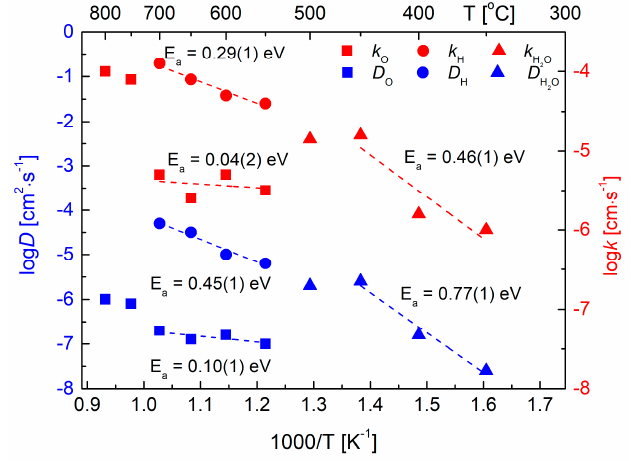
Figure 10. Temperature dependence of the transport coefficients D (blue) and k (red) with calculated values of the activation energy. Please notice description of the used symbols. Data shown in Arrhenius-type coordinates.